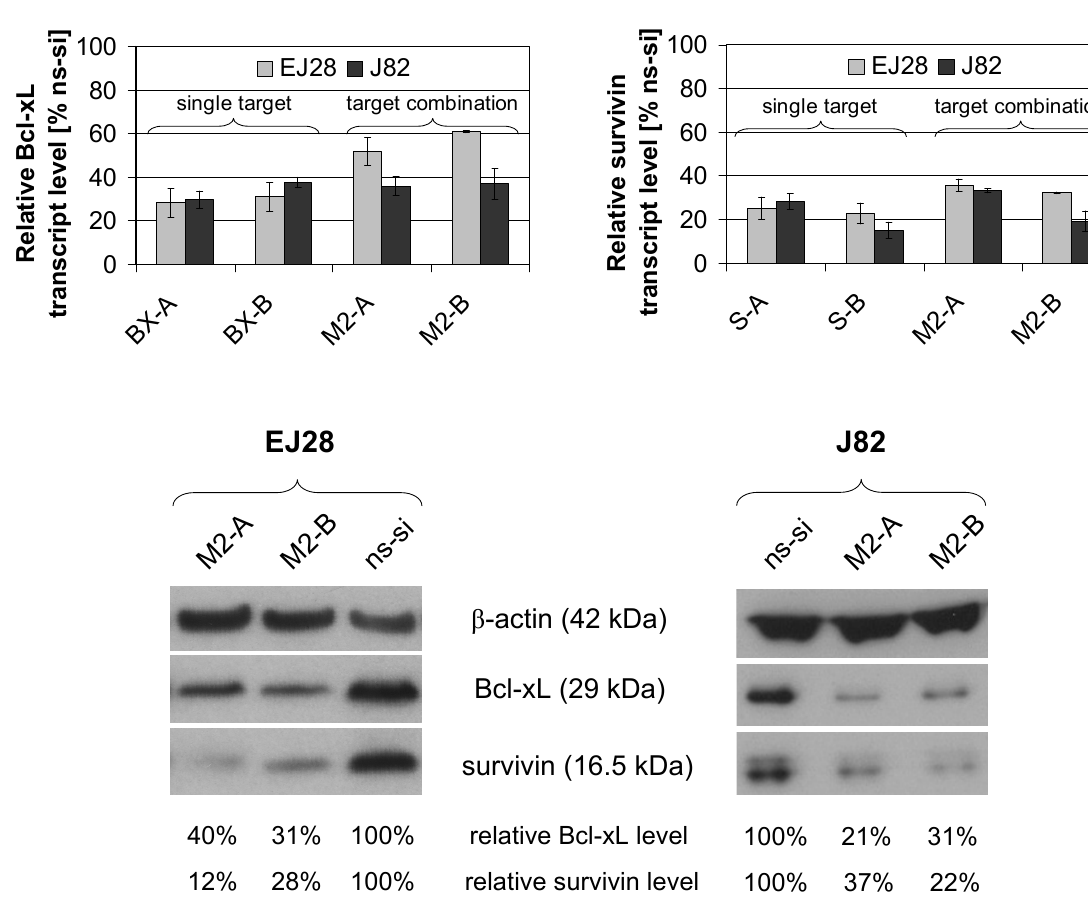
Figure 1. Effects of siRNA transfection on the expression of Bcl-xL and survivin. ( a ) Relative mRNA expression levels of Bcl-xL and survivin in EJ28 and J82 bladder cancer cells, 48 h after transfection. Expression values are normalized to the reference gene TBP and are shown relative to the control siRNA “ns-si” (=100%). Values represent averages of two independent experiments with their mean deviation; ( b ) Bcl-xL and survivin protein content detected by Western Blotting 48 h after transfection. Bcl-xL and survivin levels are shown normalized to the reference protein β -actin and relative to the ns-si